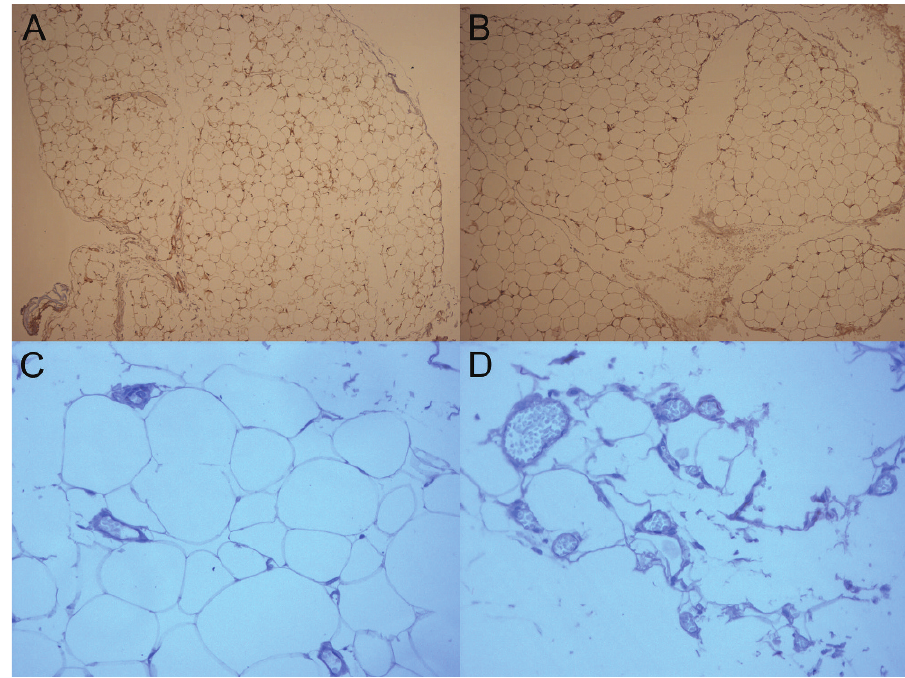
Figure 7 - On the top, VEGF immunohistochemical expression shows no noticeable difference between the initial moment (A) and the second moment (B) (100X original magnification); but the adipocyte sizes are visible bigger in the second moment. In the second line, CD31 highlights endothelial lining. There are few vessels at the fist moment (C) and more vessels at the second moment (D) (200X original